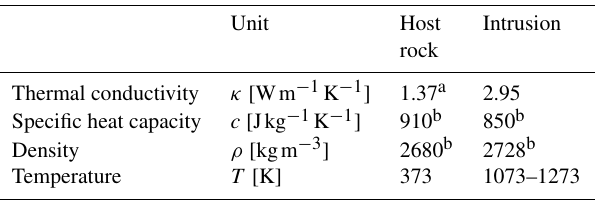
Table 2. Rock properties and initial conditions used in thermal mod-